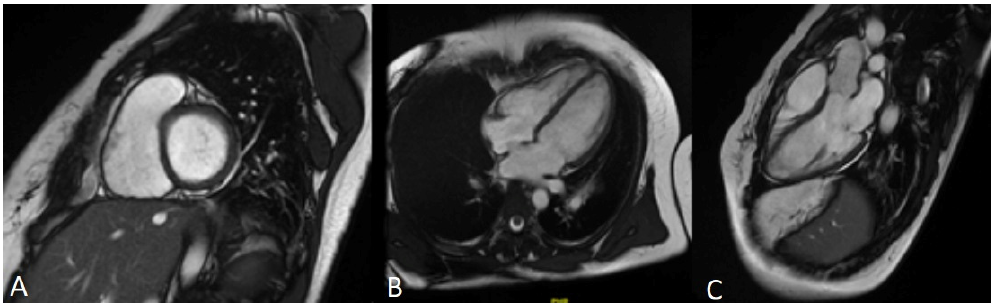
Figure 6. CMR patient IV.16. Right ventricle of normal volumes: end-diastole volume 70 mL/m 2 , end-systole volume 33 mL/m 2 and normal systolic function, ejection fraction 53%. No dyskinetic areas or focal aneurysmal dilatations were observed. There is no late enhancement in myocardial suppression sequences suggesting necrosis/fibrosis. ( A ) short axis; ( B ) four chambers; ( C ) long axis, four chambers.